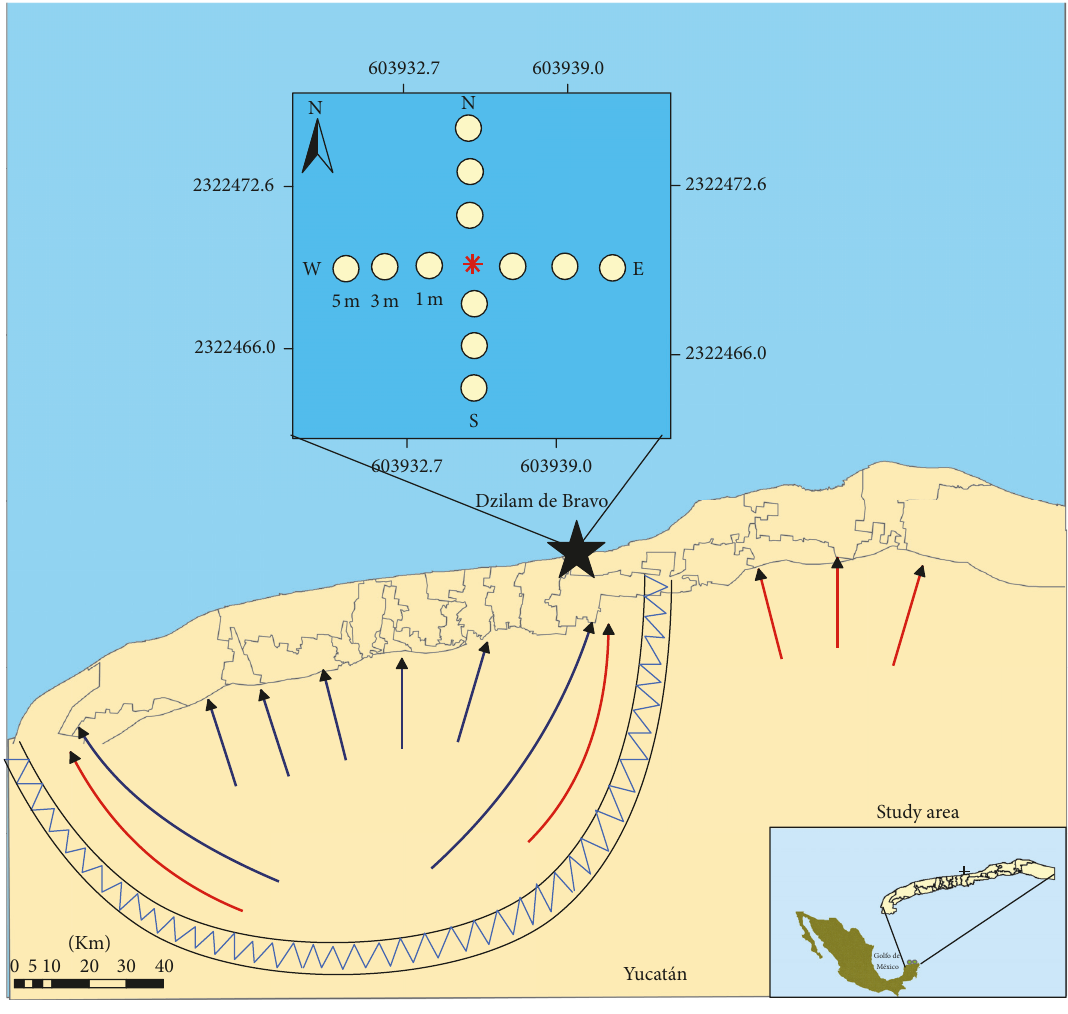
Figure 1: Study area showing regional fluxes (arrows) and spatial sampling sites distribution in the submerged groundwater discharge. Black star represents Dzilam de Bravo reserve; red asterisk represents X’Buya-Ha spring; blue zigzag line represents ring of